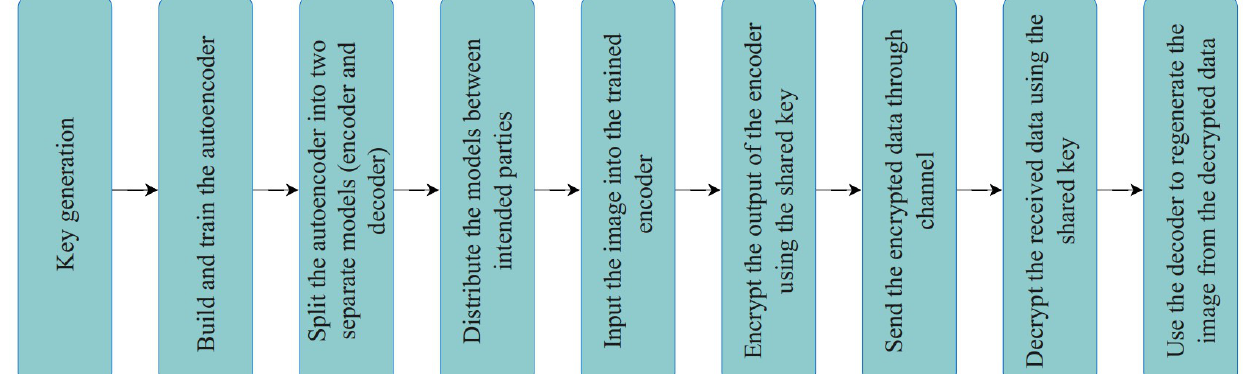
Figure 2. Proposed model steps.